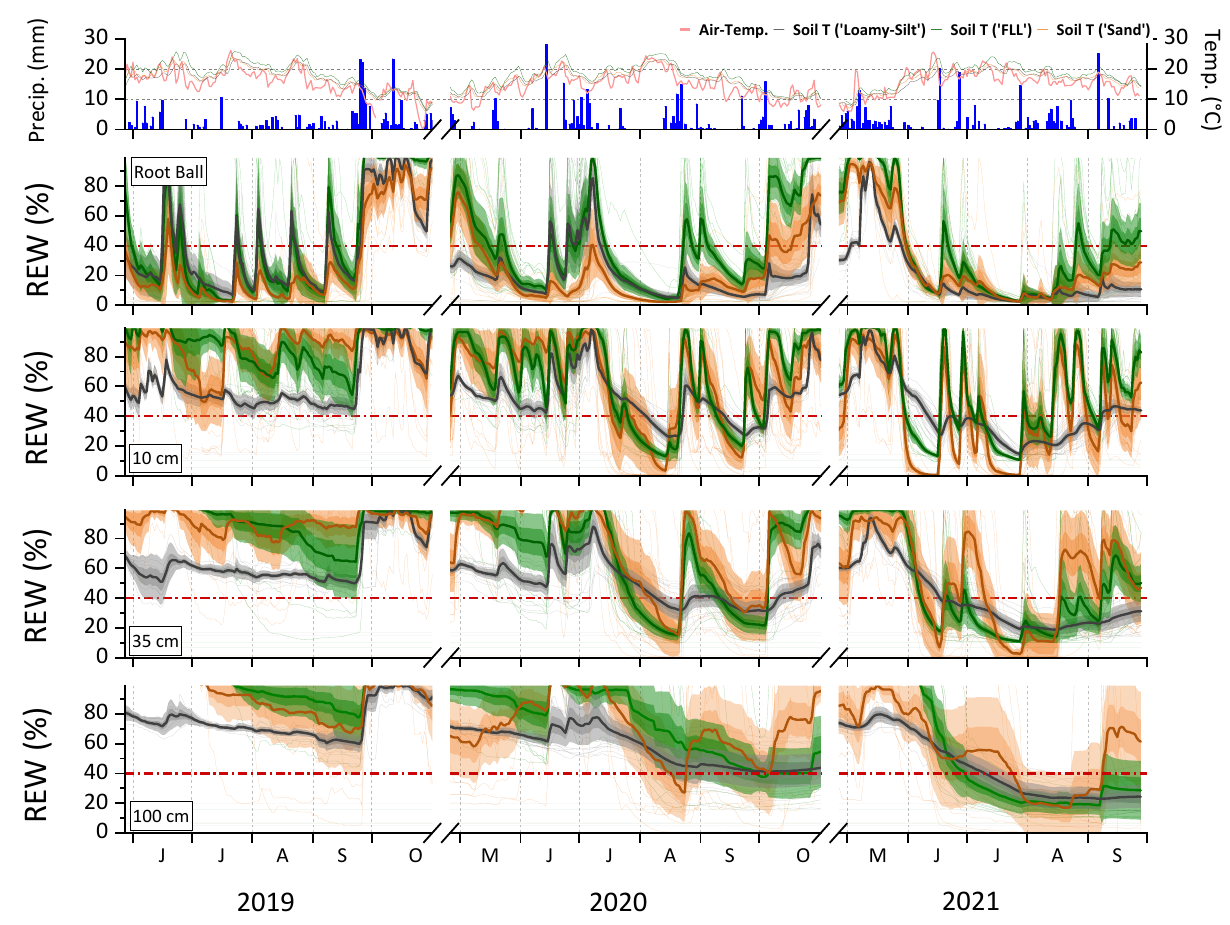
Figure 2. Dynamics of relative extractable water (REW %) at three depths and within the root ball in the three different planting soils (‘Sand‘(orange), ‘FLL‘(green), and ‘Loamy Silt‘(grey)) during the growing seasons of 2019, 2020, and 2021. Bold lines represent the means of all investigated planting pits per planting soil. Shadowed areas indicate the standard error (dark) and the standard deviation (light). Reddish dashed lines show a threshold value of 40% REW. Corresponding precipitation, air, and soil temperatures are given at the top of the graph.